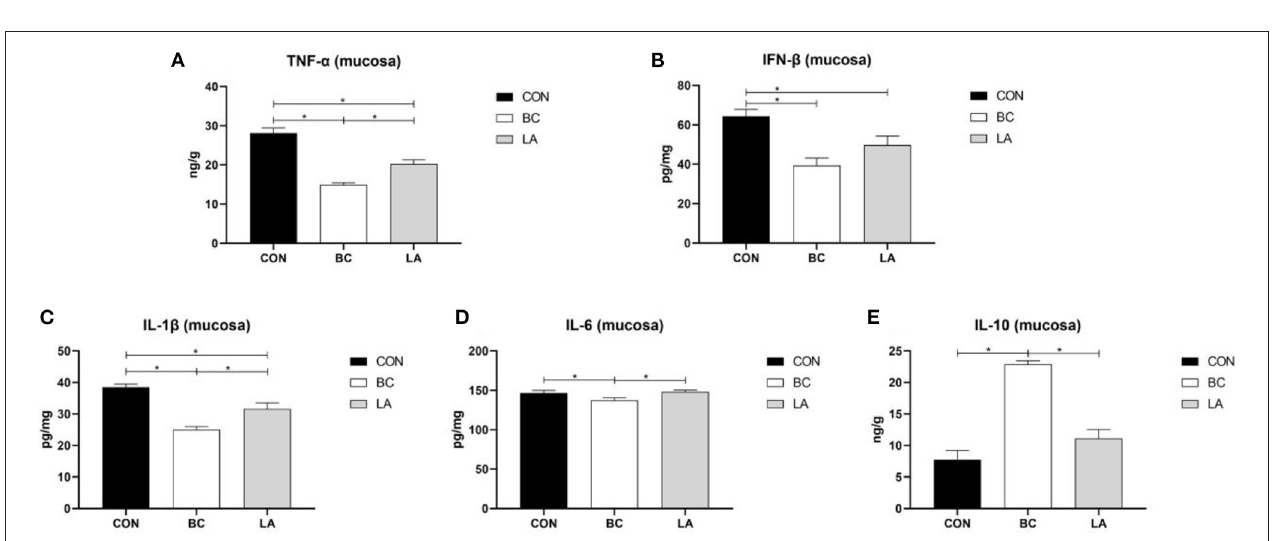
FIGURE 6 | (A–E) Effects of probiotics on jejunal mucosa inflammatory factors induced by lipopolysaccharide in broilers. CON, broilers were not treated except for the base diet; BC, broilers were supplemented with Bacillus coagulans ; LA, broilers were supplemented with Lactobacillus plantarum ; “ * ” means significantly difference. N =